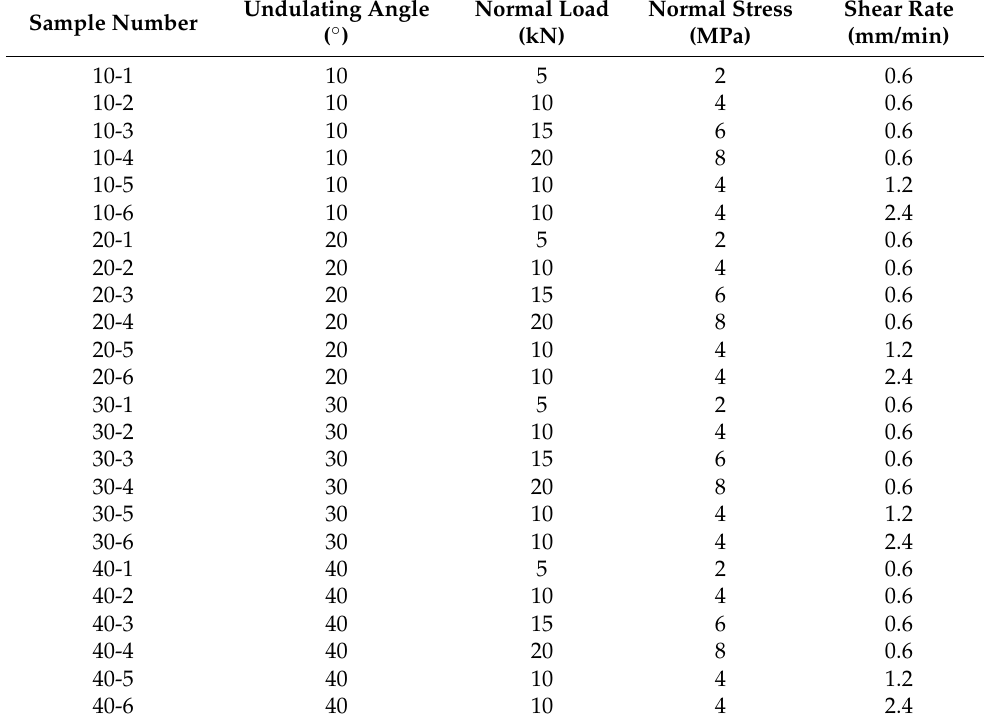
Table 1. Statistical table of experimental